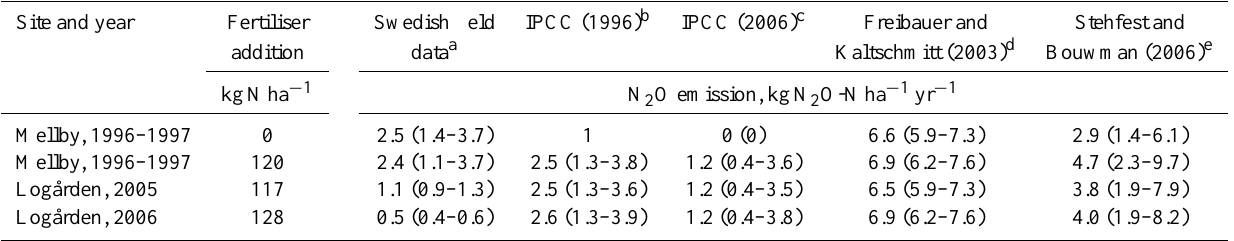
a Measured direct emission, average from measurements all year round is shown together with standard error of the mean. b IPCC (1996) emission factor 1.25% (0.25–2.25%) of N-addition in fertiliser plus a background emission of 1kgN included. c IPCC (2006) emission factor 1% (0.3–3%) of N-addition in fertiliser. Crop residues and indirect emissions are not included. d For Mellby the function for temperate western climate was used and for Log˚arden the function for alpine/sub-boreal climate. e For Mellby, factor values for temperate oceanic climate are used together with a coarse soil texture and a high soil carbon content > 3%. For the Log˚arden case, factor values for temperate continental climate, fine soil texture and soil carbon content between 1 and 3% were